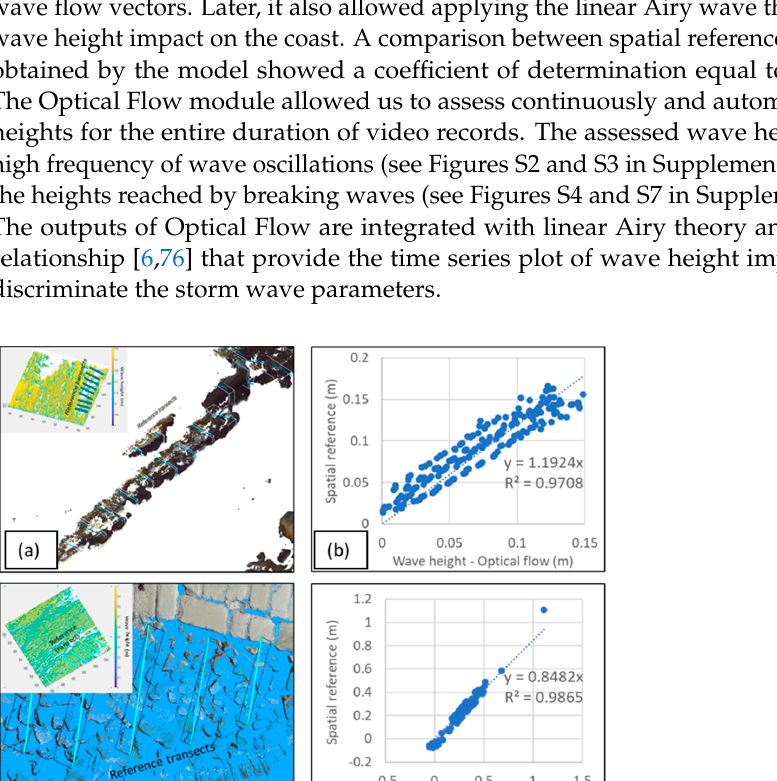
Figure 14. Tide gauge records of Catania (ISPRA) for August 2021 compared with the CNN predic- tion of S.Lucia and Massolivieri. Black and with circles represents the phases of spring tides, while gray half circle represents the phase of neap tide.